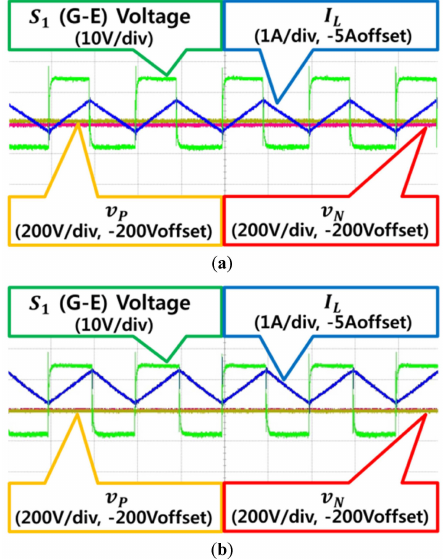
Figure 12. Performance comparison in voltage balancing: ( a ) One PI voltage control; ( b ) Two cascaded PI